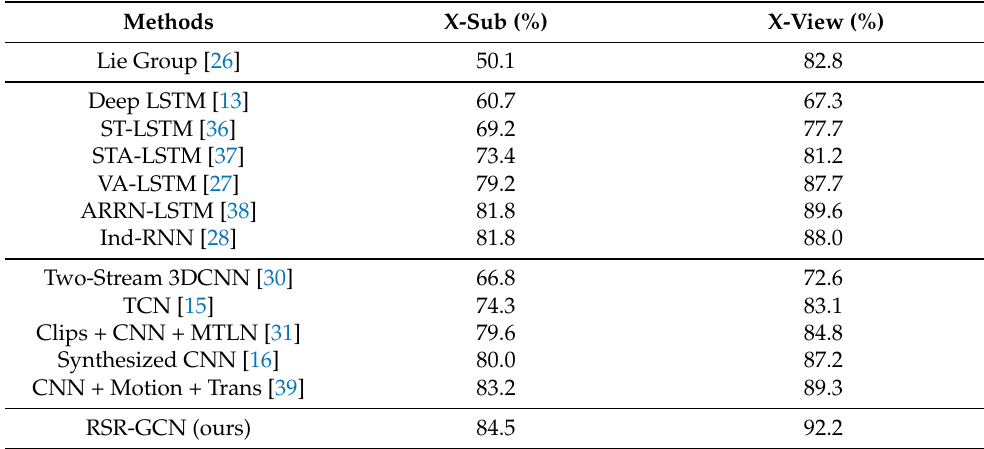
Table 3. Comparisons between STGCN and other state-of-the-art methods on the NTU-RGBD dataset.